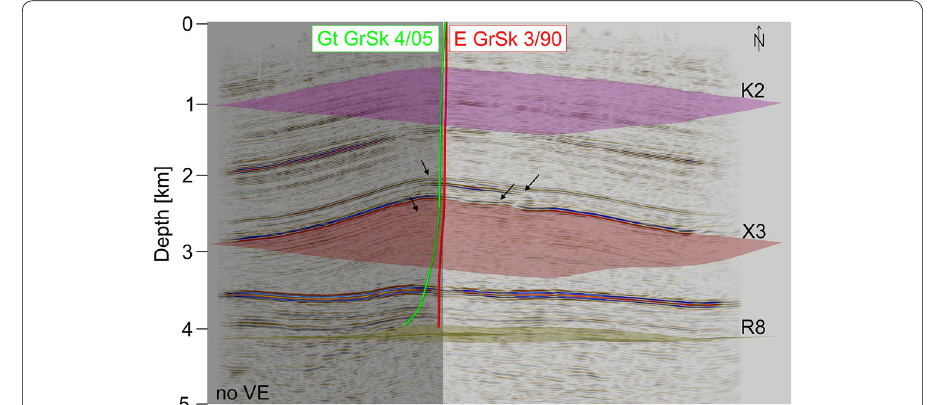
Fig. 7 Composite of the seismic volume (migrated, depth) with selected horizons (view towards north). They exemplify the rather transparent upper Tertiary sediments (K2), the continuous internal Zechstein structure (X3), and the lowermost interpretable Rotliegend horizon (R8). The vertical sections are blended with the drilling paths, used for well tie and synthetics (cf., Fig. 2) to calibrate the reflectors. Several reflectors can be traced with high confidence across the volume, exceeding former interpretations (reflector nomenclature according to Reinhardt